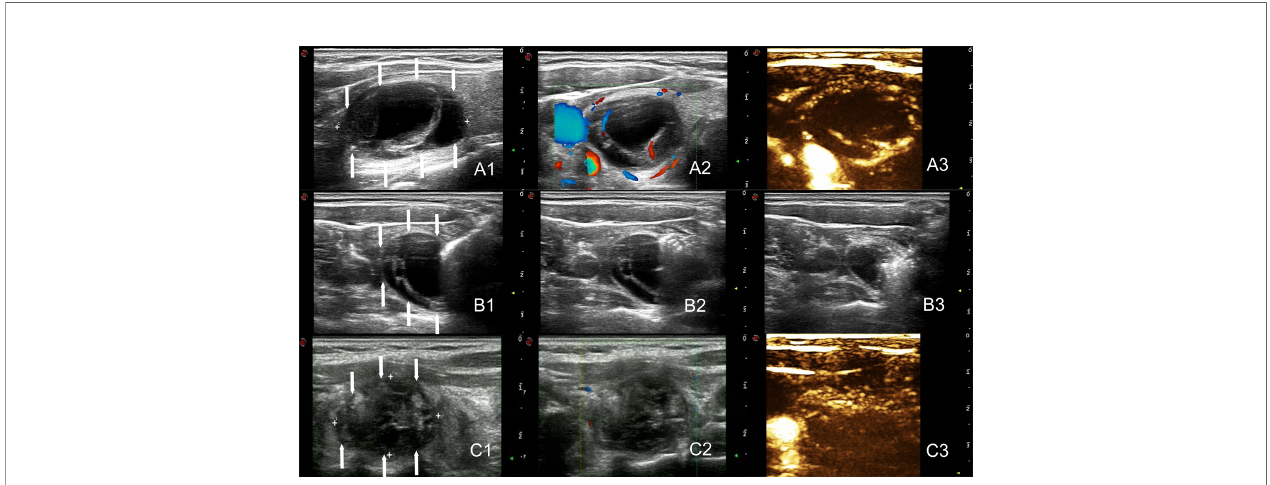
FIGURE 3 | The arrows point to the nodules. Two-dimensional ultrasound, CDFI and CEUS images before treatment of the nodule (Volume = 9.1ml, A1 – A3 ). Images of the tract ablation in group A. One needle tract ablated prior to cyst fl uid aspiration, followed by an additional ablation of the entire nodule. (B1 – B3) . Two-dimensional ultrasound, CDFI and CEUS images immediately after the ablation of the nodule (Volume = 4.4ml, C1 – C3